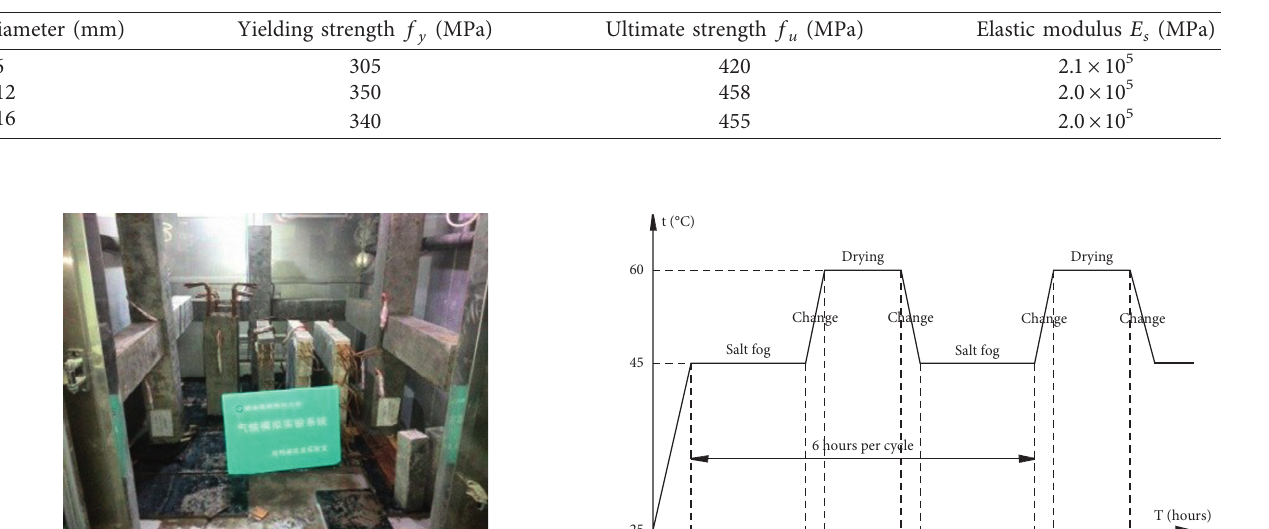
Figure 1: Dimensions and reinforcement details of the specimens (unit: mm). Table 2: Mechanical properties of the reinforcement bars.